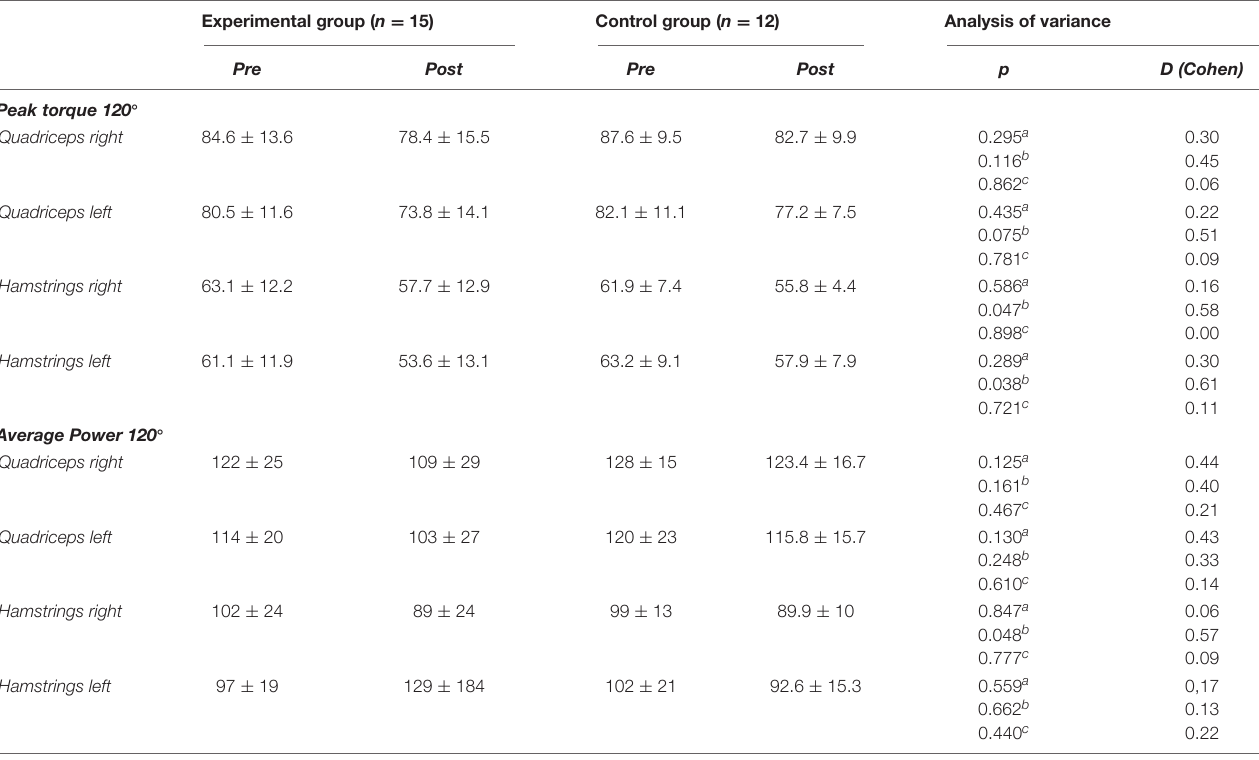
TABLE 10 | Comparison of isokinetic parameters values at 120 ◦ .s − 1 velocity between experimental and control groups before (pre) and after (post) the 8-week trial. Experimental group ( n = 15) Control group ( n = 12) Post Peak torque 120